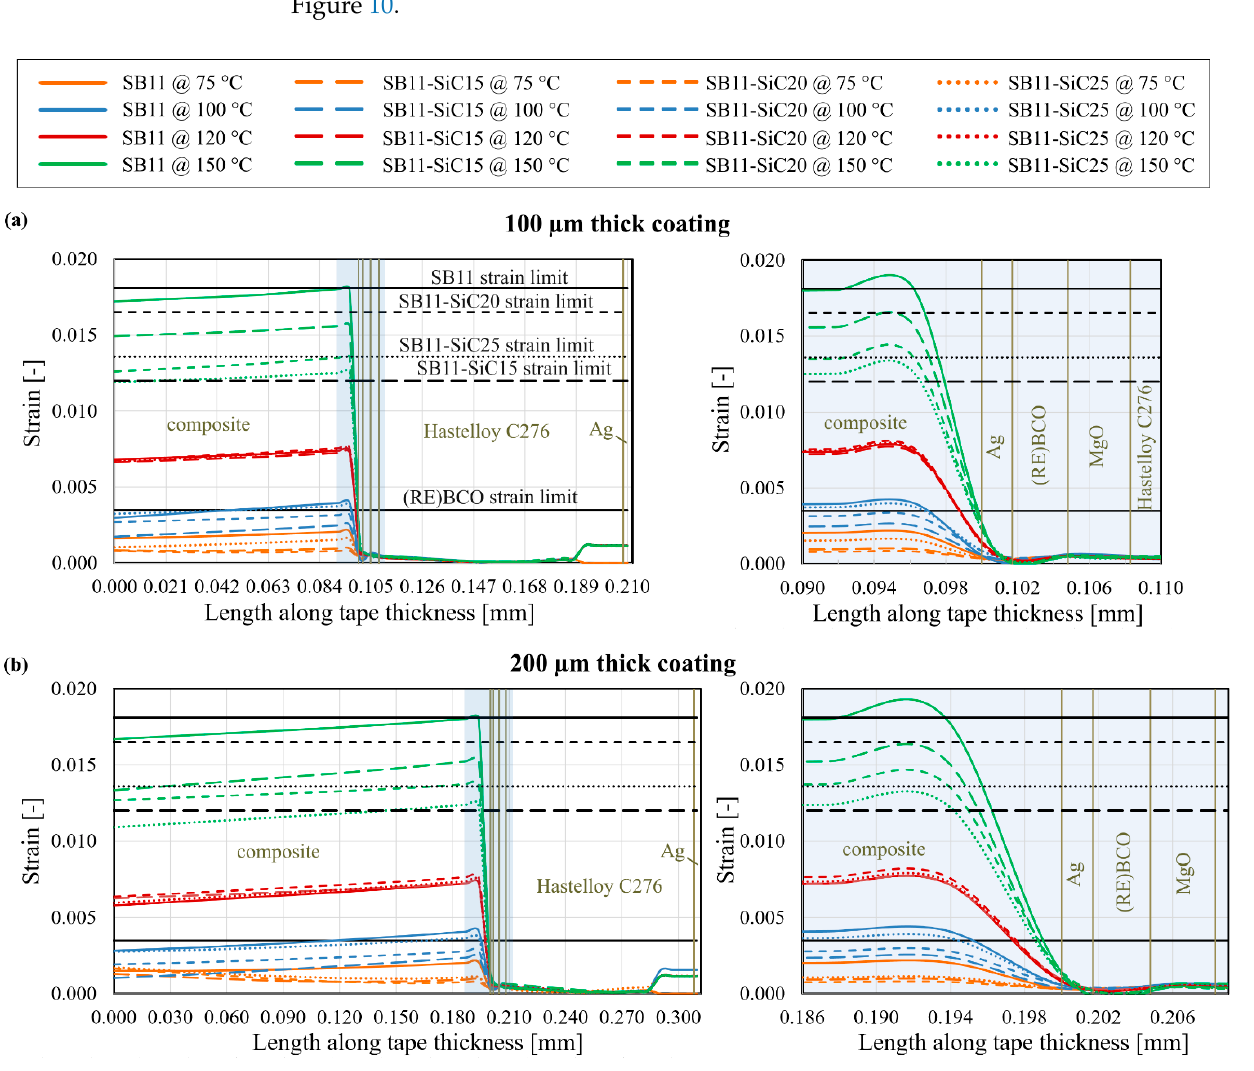
Figure 9. Equivalent strain distribution along the transversal path in the middle of the modified HTS tape at different quenching temperatures: ( a ) model with 100 µm and ( b ) 200 µm thick composite coating and different SiC content. For better clarity, the blue regions in plots on the left-hand side are magnified on the right hand side.